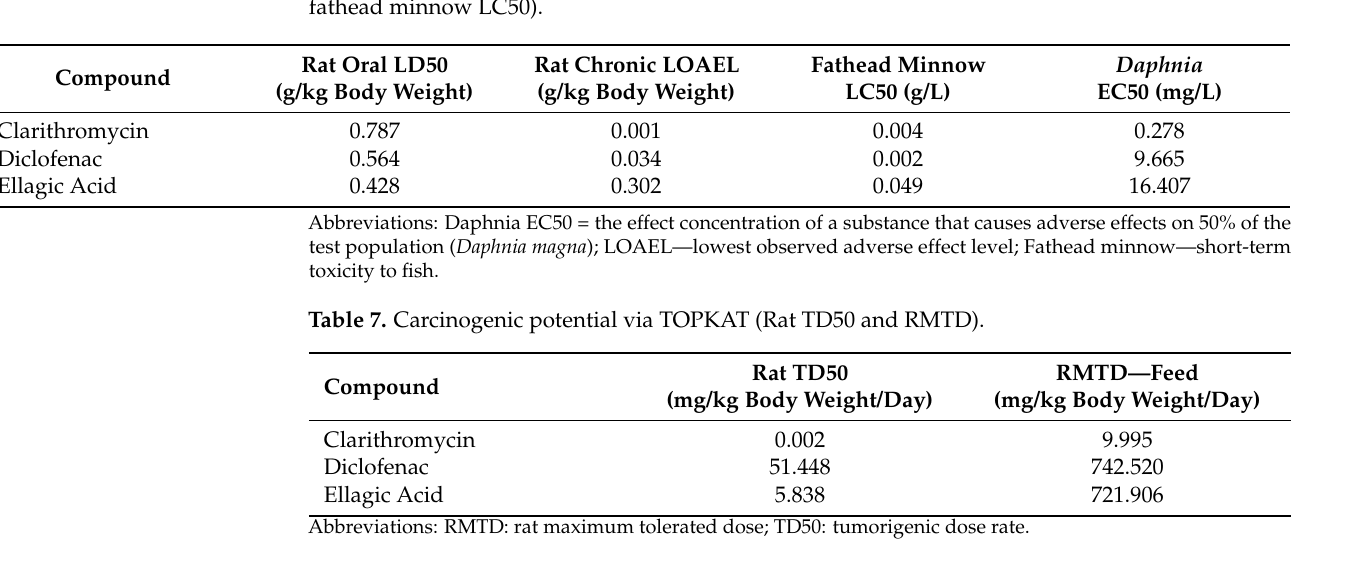
Table 6. Toxicity risk prediction via TOPKAT (Rate oral LD50, Daphnia EC50, rat chronic LOAEL, fathead minnow LC50).